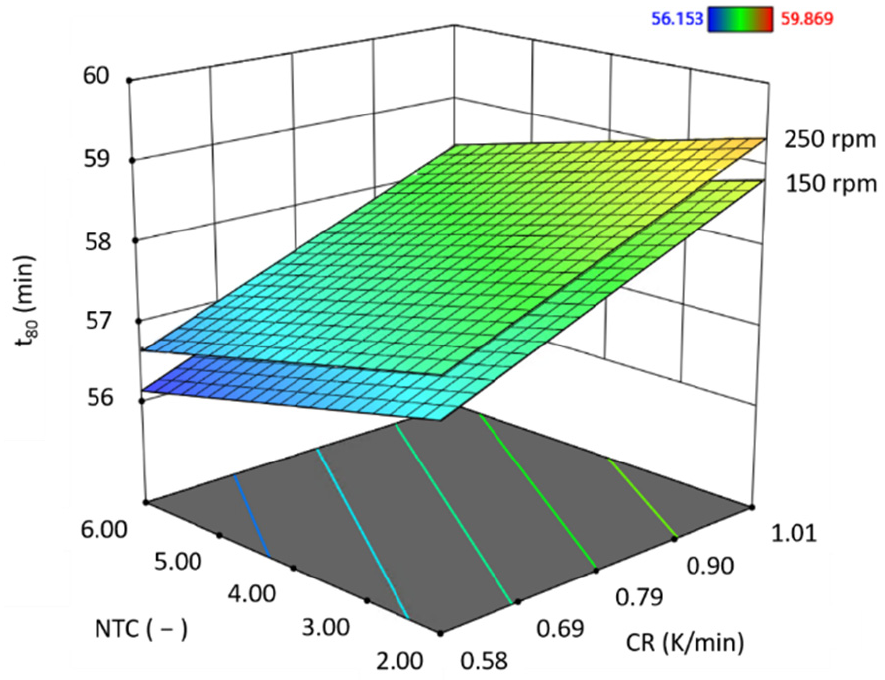
Figure 6. Primary drying time ( t 80 ) as a function of the number of temperature cycles (NTC) and the cooling rate (CR) in the scraped surface heat exchanger is shown for two different scraping speeds of 150 rpm and 250